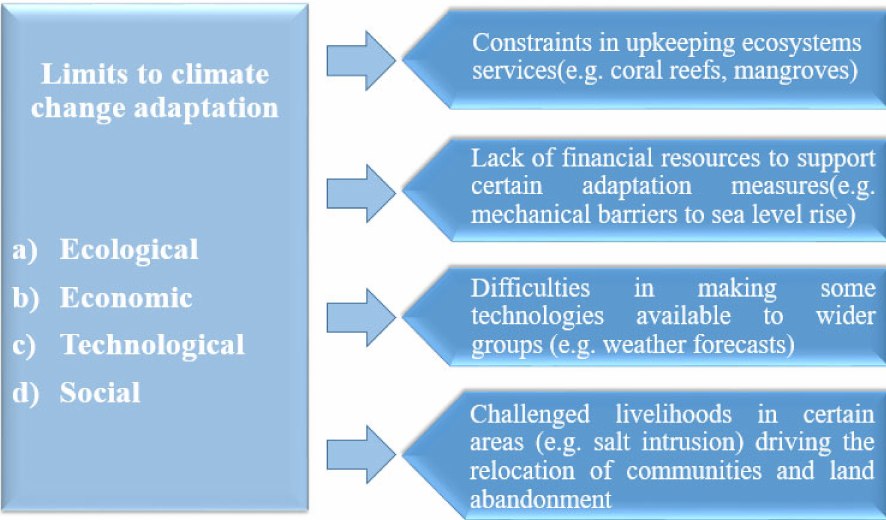
Figure 1. Examples of the limits to climate change adaptation.